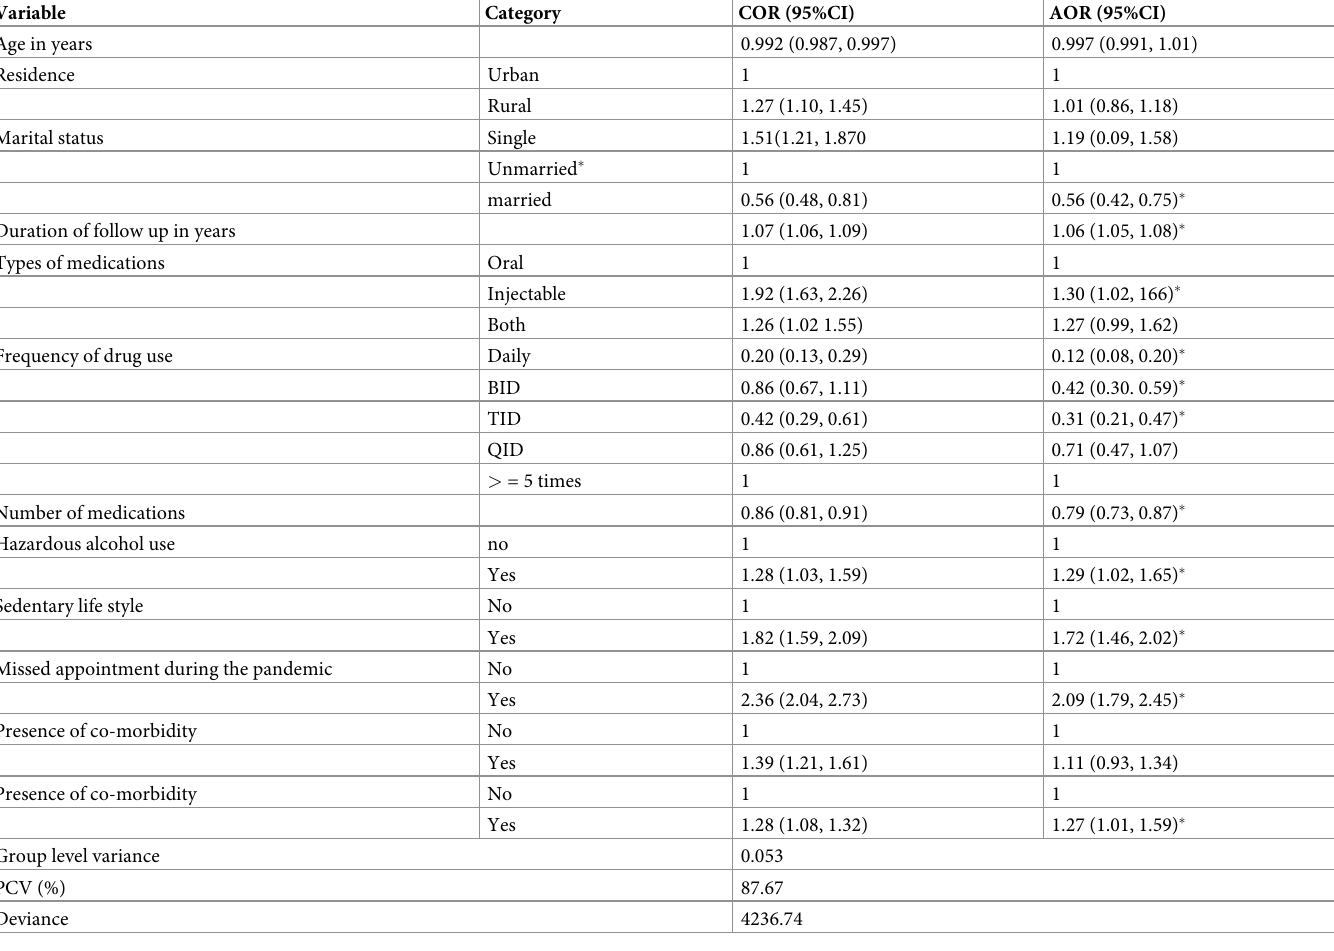
Table 2. Multivariable binary logistic regression mixed model for associated factors of Poor treatment control among ambulatory Diabetic and/or Hypertensive